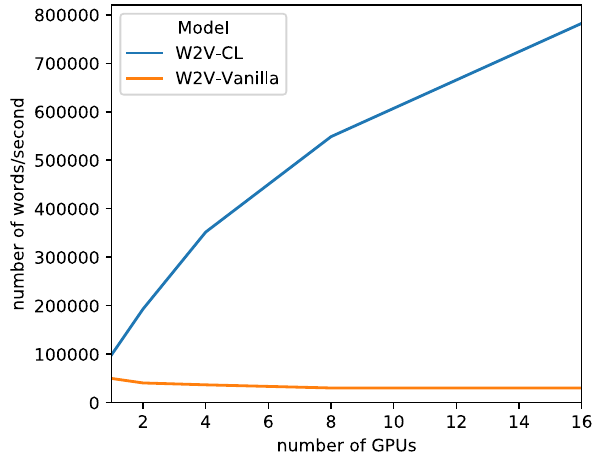
Fig. 18 Training speed of word-level word embeddings with different number of